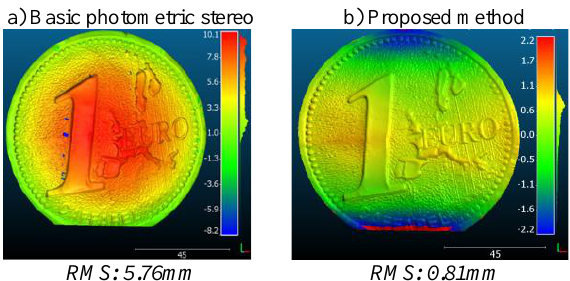
Figure 6. Point-to-point comparison results for the shiny surface shaped like a Euro coin (100 mm diameter).